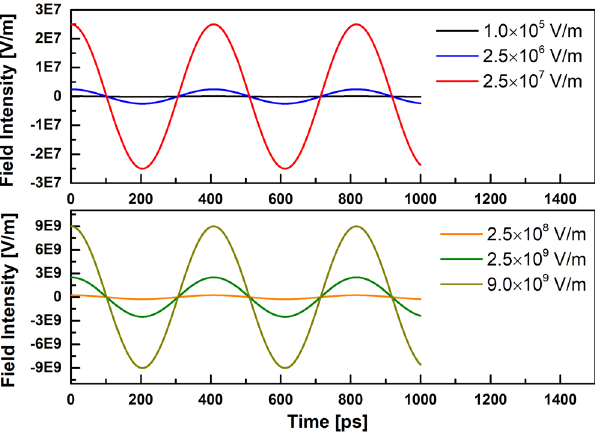
Figure 8. The amplitude of applied microwave